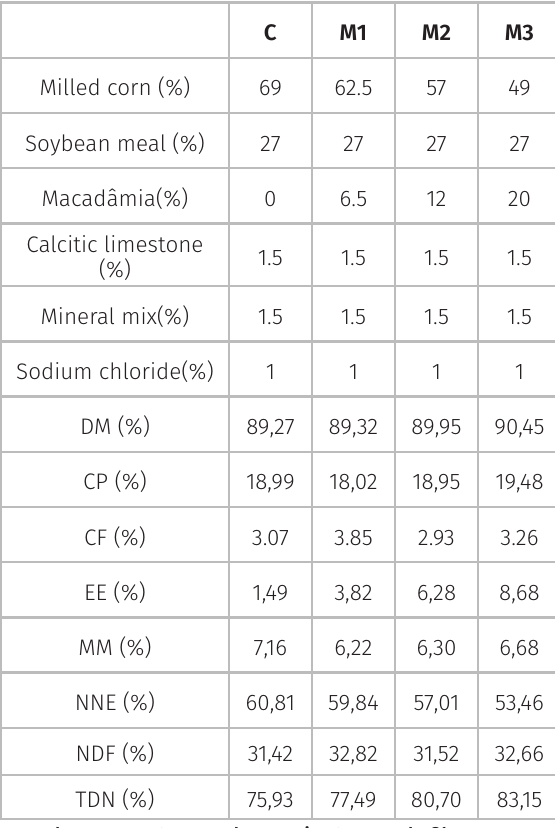
Table II. Formulation and nutritional composition of the concentrates, according to the level of inclusion of the Macadamia nut